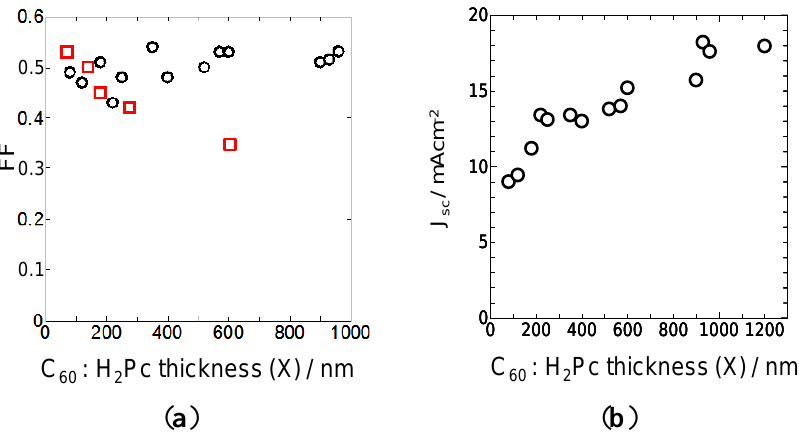
Figure 8. ( a ) Dependence of fill factor (FF) on the C :H Pc i -interlayer thickness ( X ) for 60 2 p-i-n cells incorporating C purified three times by single-crystal formed sublimation 60 (black open dots) and for p-i-n cells incorporating C purified by conventional train 60 sublimation under vacuum (red open squares); ( b ) Dependence of short-circuit photocurrent density (J ) on X . sc